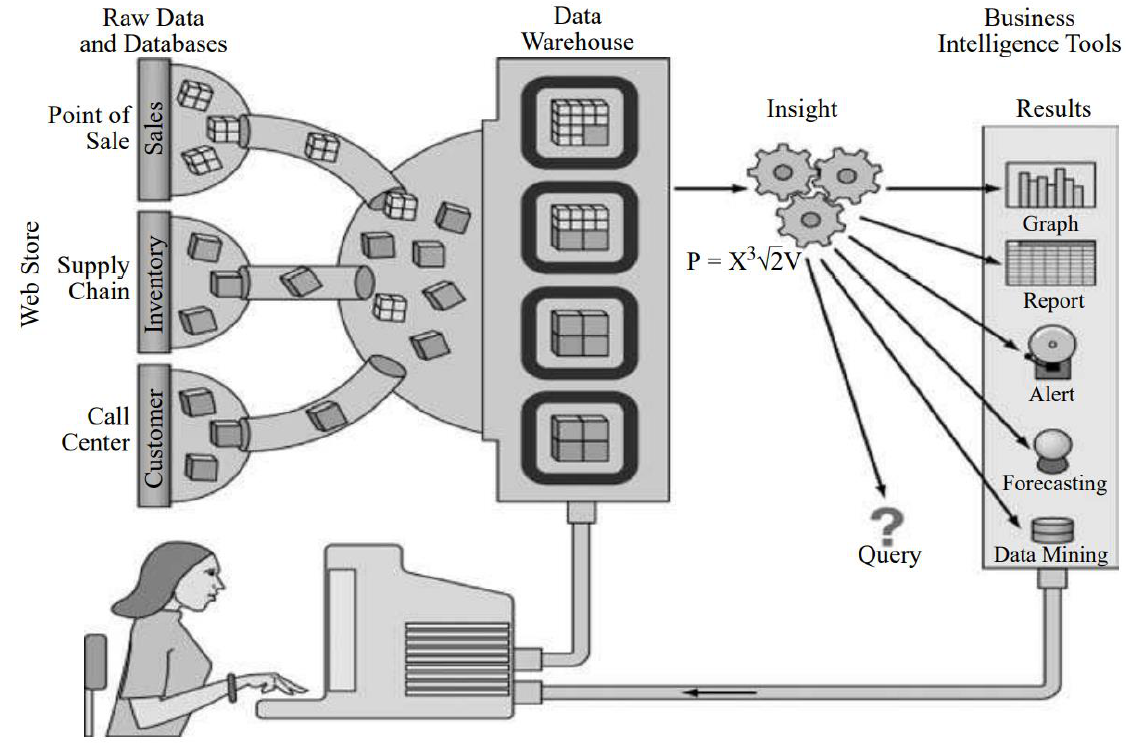
Figure 1: Understanding of Business Intelligence (Source: Moss (2003)) Traditionally, info systems have been created to process discrete transactions to automate tasks including order entry or maybe account transactions [11]. These methods aren't created to help users extract data at various aggregation amounts and use advanced techniques for enterprise broad data analysis. The Figure one shows an understanding of BI. A BI process in various other phrases is a mix of information warehousing and choice support systems. The figure additionally reveals how information from disparate sources could be extracted, as well as kept to be retrieved for evaluation [12]. Details from supply chain, point of product sales, as well as call centers are collected and kept in a data warehouse. Utilizing BI query reporting equipment, the info is examined for hidden helpful